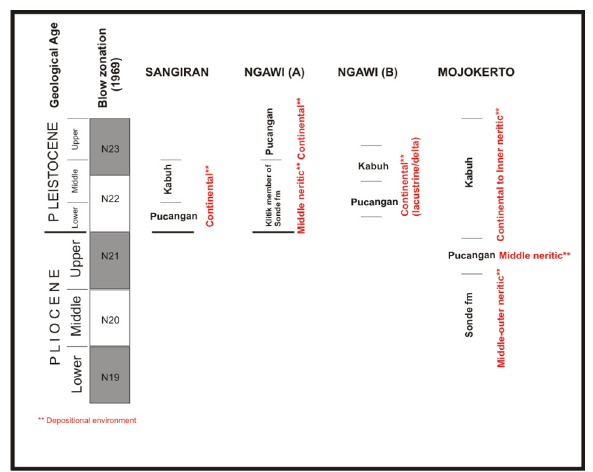
Figure 10. Compilation of the stratigraphy